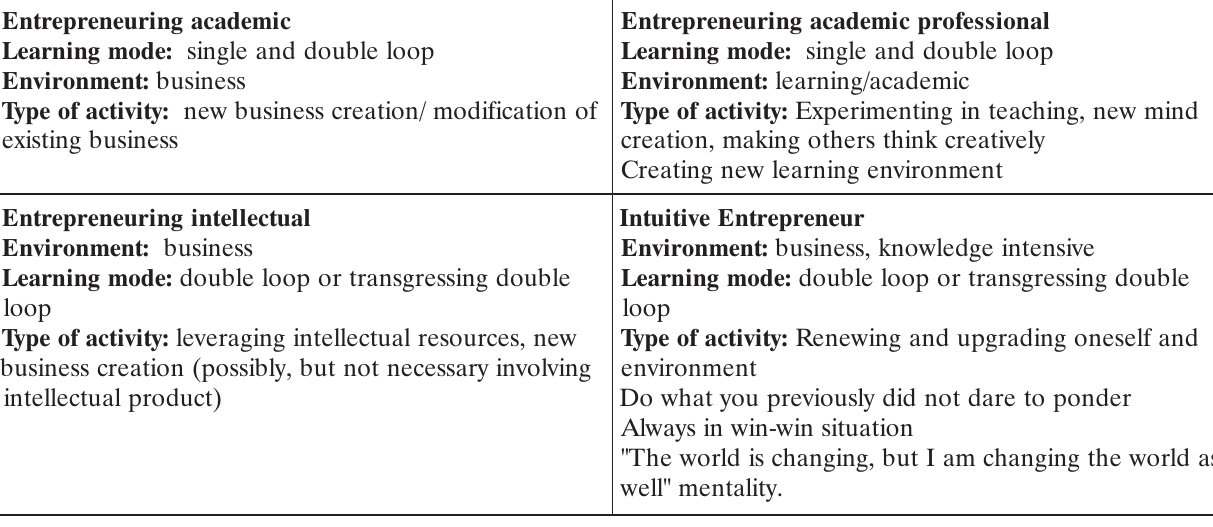
Table 2. Emerging typology of